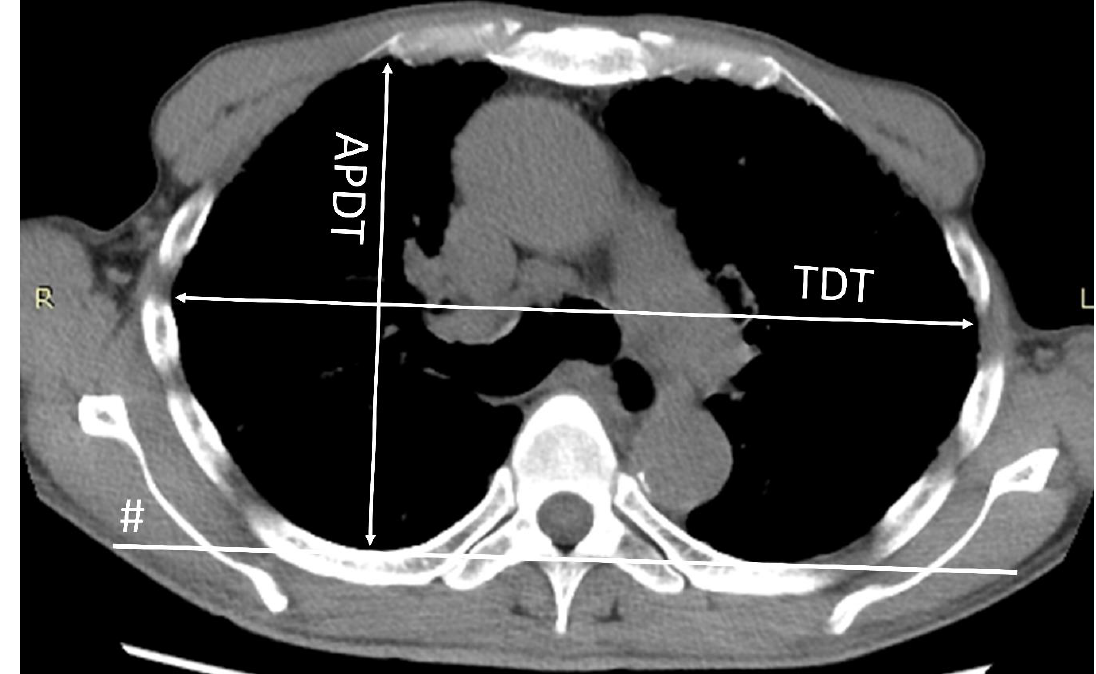
Figure 1. The transverse diameter of the thoracic cage (TDT) was determined as the longest transverse diameter of the thoracic cage measured parallel to a line (#) that runs along the rearmost points of the bilateral 6th ribs in the horizontal section of the CT scan. The anteroposterior diameter of the thoracic cage (APDT) was determined as the longest distance of the anteroposterior dimension of the thoracic cage measured perpendicular to the line along the rearmost points of the sixth thoracic vertebra (line #).